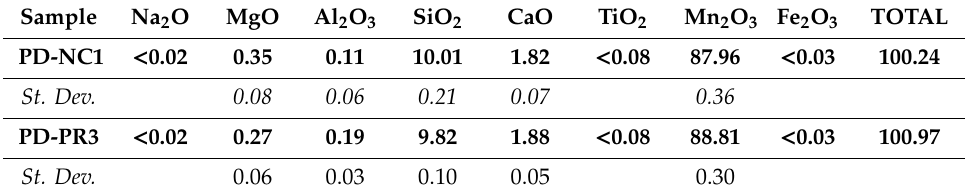
Figure 6. Micro-Raman spectrum, in the region from 100 to 1100 cm − 1 , of manganese-containing inclusion identified in tessera PD-PR3, compared with the reference Raman spectra of braunite and neltnerite (RRUFF database; RRUFF ID for braunite and neltnerite also shown). Note a better match of PD-PR3 inclusion with the spectrum of braunite R050390, having a chemical formula equal to (Mn 2 + 0.96 Ca 0.17 ) Mn 3 + 6 SiO 12 . Similar micro-Raman spectra are identified in all the other Padova tesserae with manganese-containing inclusions. Table 3. Mean chemical compositions (in bold) and standard deviations (in italic) of manganese-containing inclusions in tesserae PD-NC1 and PD-PR3, which are representative of all the crystals analysed in Padova tesserae light brown / amber and purple in colours, respectively. Note that chemical compositions of inclusions are quite comparable (EMPA data are expressed as percentual concentrations of element oxides; total manganese and total iron are expressed as Mn 2 O 3 and Fe 2 O 3 , respectively; the number of analyses performed on each sample is about